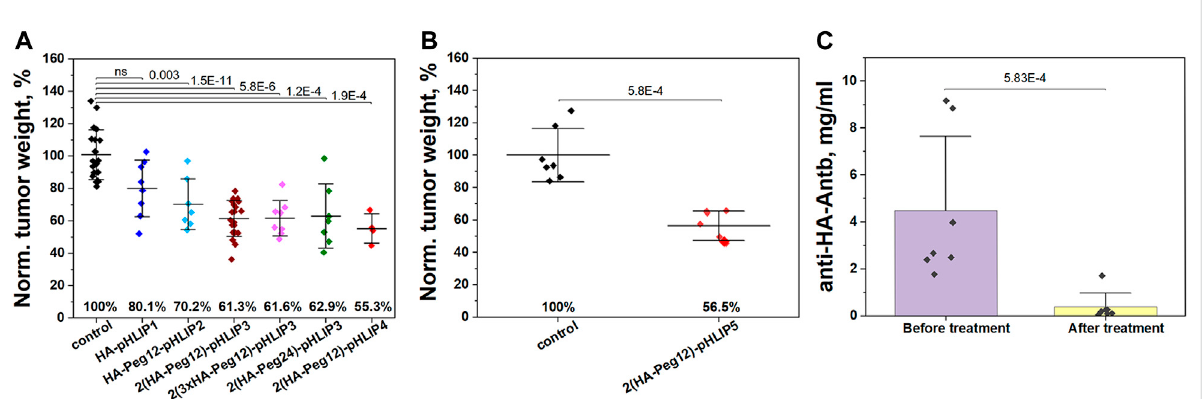
FIGURE 8 Therapeutic ef fi cacy of HA-pHLIP. (A) Normalized weight of murine breast 4T1 tumors collected from mice immunized with KLH-HA/CFA and KLH-HA/IFA and treated with HA-pHLIP agents is shown. (B) Normalized weight of murine melanoma B16F10 tumors collected from mice immunized with 2 injections of KLH-HA/AddaVax and treated with 2(HA-Peg12)-pHLIP5 is shown. The mean weight of tumors in the control group was taken as 100%. At the 0.05 level the distributions of tumor weight in the control (untreated) group and HA-pHLIP (treated) groups are statistically differentasestablishedbytheKolmogorov-Smirnov two-tailednon-parametric test(except for theHA-pHLIP1 agentinpanel A). (C) The amountofanti-HAantibodyinserumobtainedfrommice(bearingB16F10tumors)beforethetreatmentwasinitiatedandaftertreatmentwith2(HA- Peg12)-pHLIP5 was completed and animals were euthanized. Statistical signi fi cance was established by the Kolmogorov-Smirnov two-tailed non- parametric